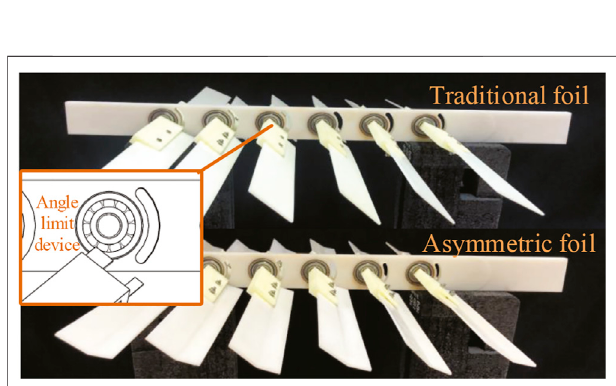
FIGURE10| Propellermini-prototypesmadeby3Dprintingwithdensity around 1 g / cm 3 (material density 1.25 g / cm 3 × fi ll rate 80%). Upper side: propeller with the tradition foils; Lower side: propeller with our asymmetric